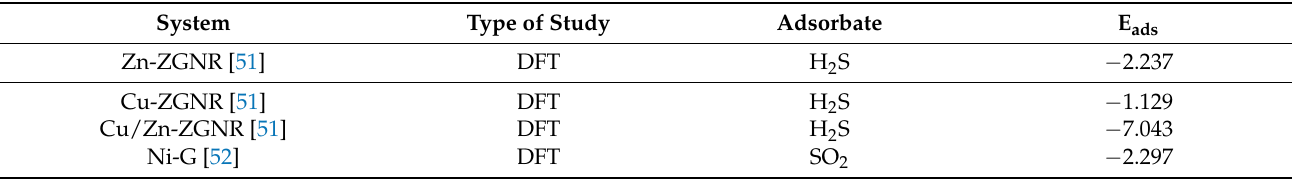
Table 8. Summary of adsorption energies E ads (in eV) for different TM-doped graphene systems and adsorbates. The type of study is also